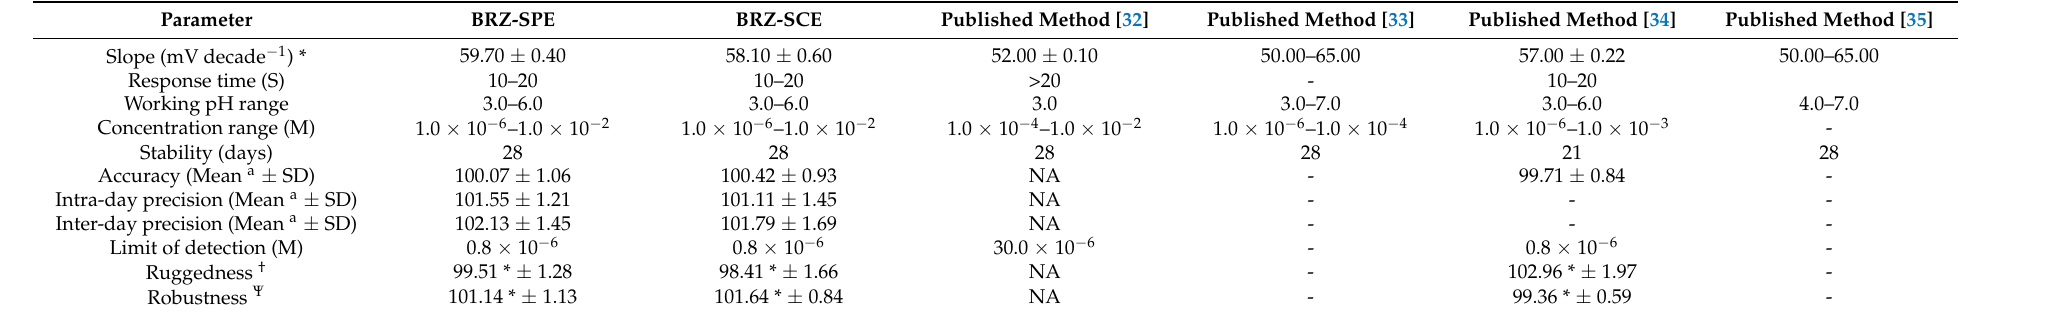
Table 1. Electrochemical response characteristics of the fabricated